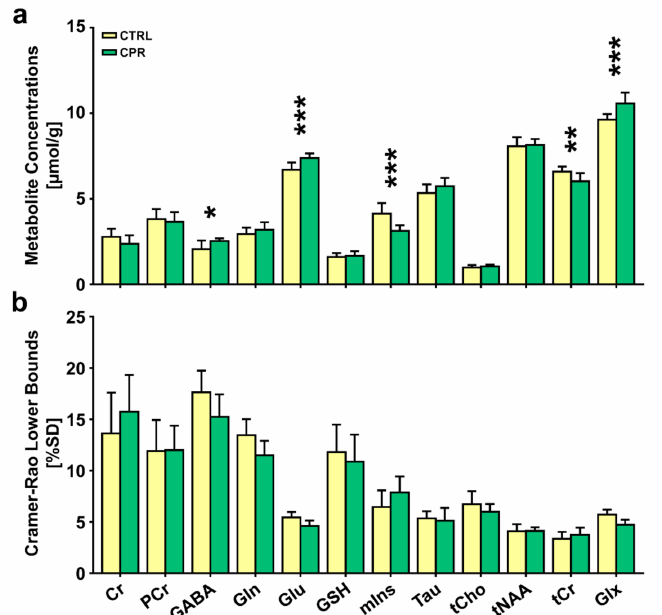
Figure 3. Bar graph indicating the mean cerebral metabolite concentrations ( a ) and Cramer-Rao lower bounds (CRLBs) ( b ) in the right hippocampal region of control (CTRL) and cuprizone-treated (CPR) rats, quantified using Linear Combination of Models software. The vertical lines on each of the bars indicate the (+) standard deviation of the mean values. * p < 0.05; ** p < 0.01; *** p < 0.005. Cr, creatine; GABA, gamma-aminobutyric acid; Gln, glutamine; Glu, glutamate; Glx, Glu + Gln; GSH, glutathione; mIns, myo-inositol; PCr, phosphocreatine; SD, standard deviation; Tau, taurine; tCho (total Cho), GPC (glycerophosphocholine) + PCh (phosphocholine); tCr (total Cr), Cr + PCr; tNAA (total NAA), NAA (N-acetylaspartate) + NAAG (N-acetylaspartylglutamate). Figure 4 illustrates the selected metabolite ratios of interest obtained from the hip- pocampal region of both groups. The Glx/tCr (1.465 ± 0.097 vs. 1.758 ± 0.091; p < 0.001), Glu/tCr (1.018 ± 0.090 vs. 1.231 ± 0.094; p < 0.001), and GABA/tCr (0.314 ± 0.076 vs. 0.422 ± 0.033; p = 0.002) ratios in CPR rats were significantly higher than those in CTRL rats.